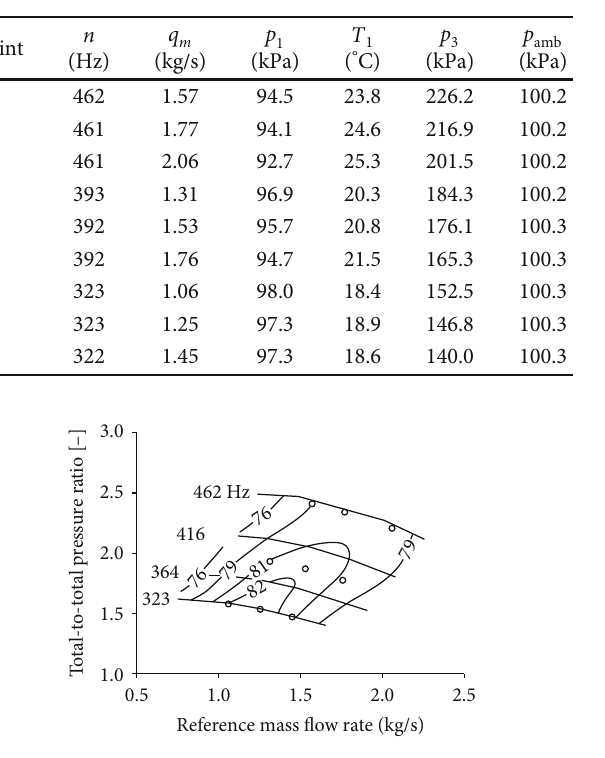
Figure 3: Compressor performance map with the measured operating points. Table 2: Parameters of the studied centrifugal compressor at the point of maximum axial thrust (point 9) used in the method proposed by